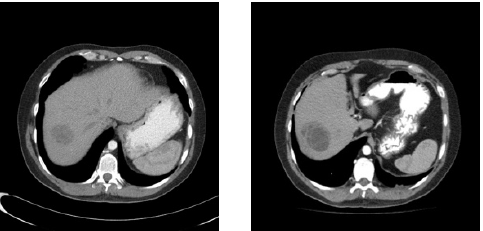
Figure 3. From left to right, Post-chemotherapy unenhanced CT Scan showing improvement in liver metastases and 18 month follow up enhanced CT scan showing enlarging dominant liver metastases.